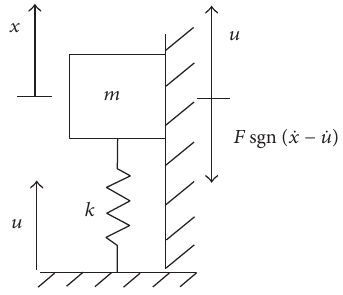
Figure 1: A one-degree-of-freedom system isolation configuration with Coulomb friction subjected to a base